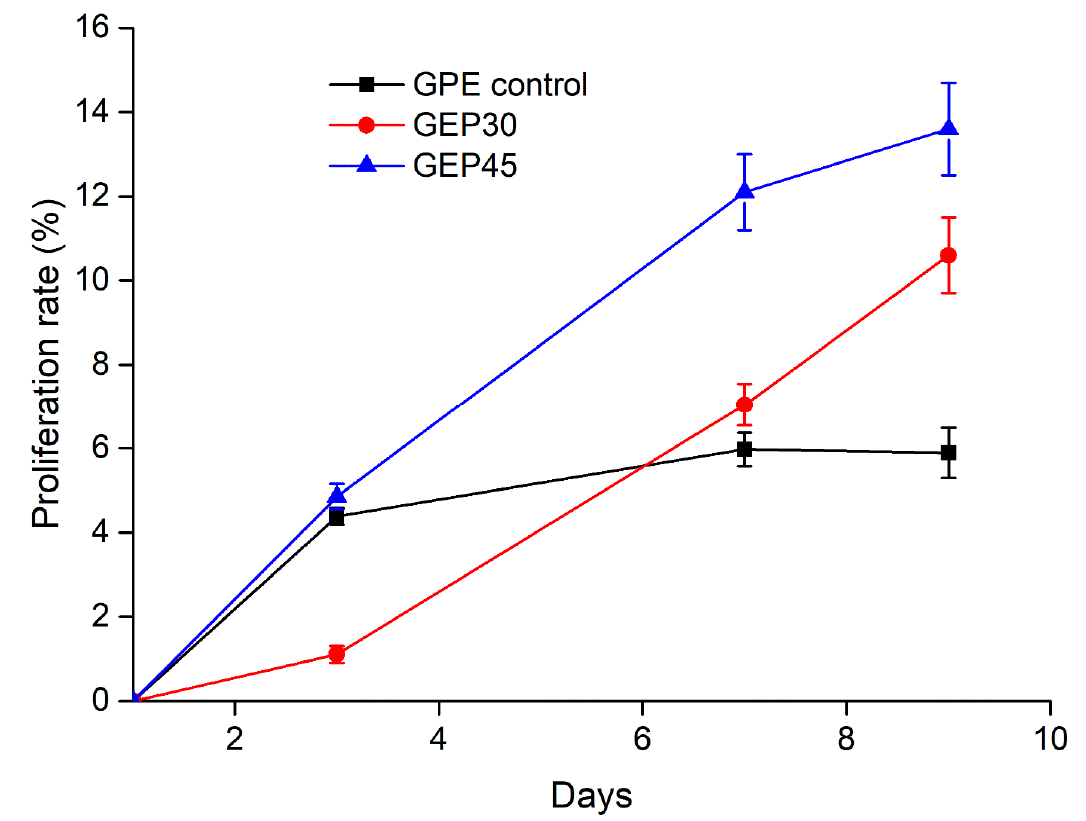
Figure 6. Cell proliferation analysis of NHDFs encapsulated in GEP45, GEP30 and GPE control at day 0, 3, 7 and 9. The single-parameter histograms of fluorescence EdU-488 levels for flow cytometry data was used to estimate the percentage of proliferation cells during 24 h EdU incubation. (“ Pro” and “Non-pro” represents the percentage of proliferative and nonproliferative cells respectively).